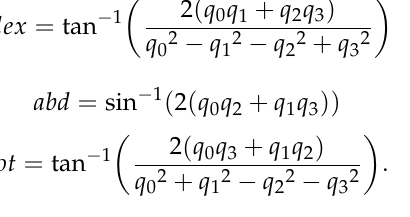
→ → → X (cid:48) , Y (cid:48) , Z (cid:48) ) in the Earth ∆𝑞(cid:3554) (cid:3040)(cid:3028)(cid:3034) . mag